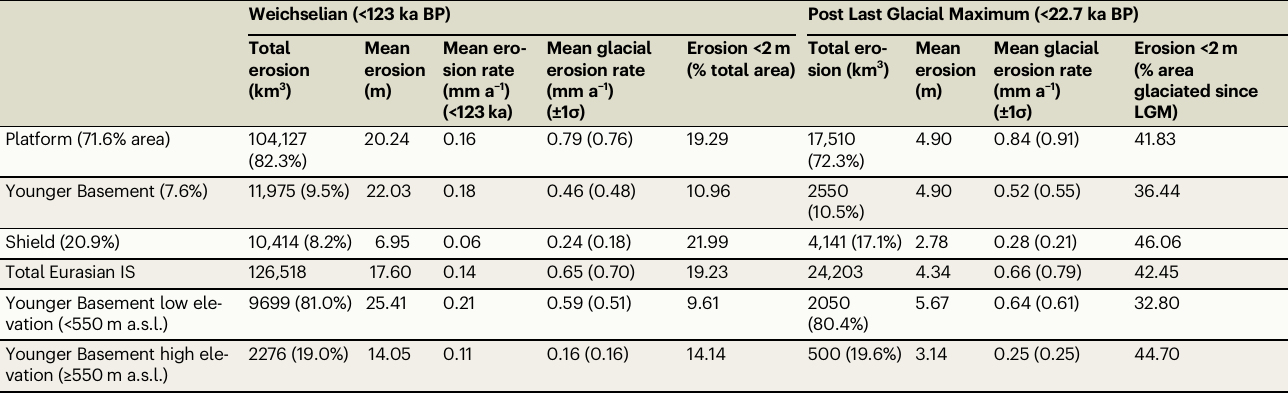
Table 1 | Breakdown of predicted glacial